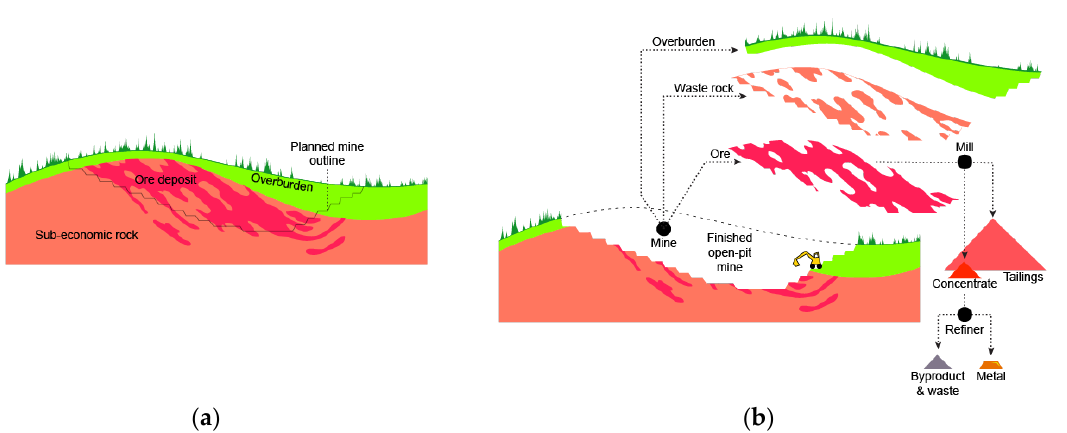
Figure 3. Basic mining and metal refining terminology (adapted from groundtruthtrekking.org). Before ( a ) and after ( b ) starting mining operation.